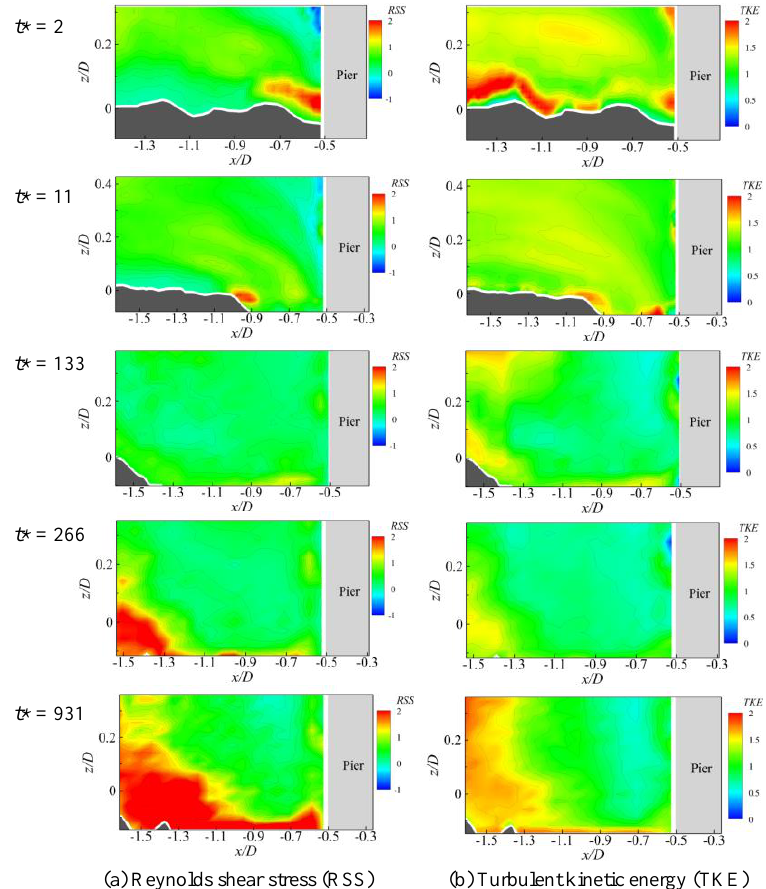
Figure 13. Contours of Reynolds shear stress and turbulent kinetic energy at different time in the pier scouring process.